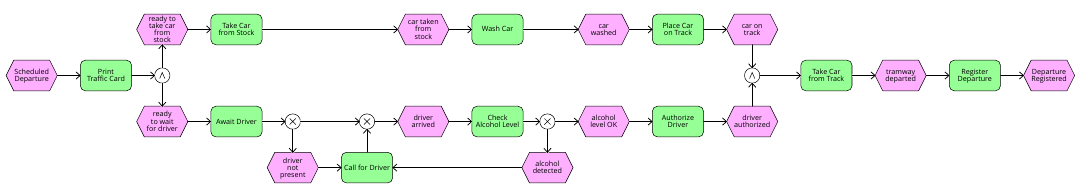
Figure 6. An example of an equivalent model to the spreadsheet-based process description presented in Table 18.